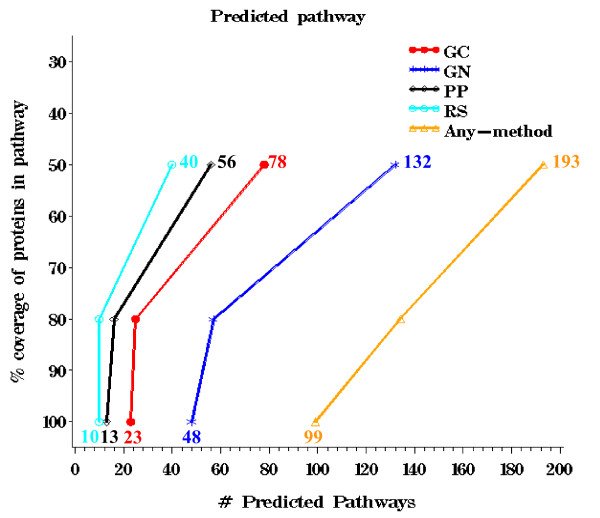
Percentage of proteins in a pathway with at least one linkage in each method, using confidence threshold 0.6. Numbers above and below each line represent 50% and 100% coverage, respectively.